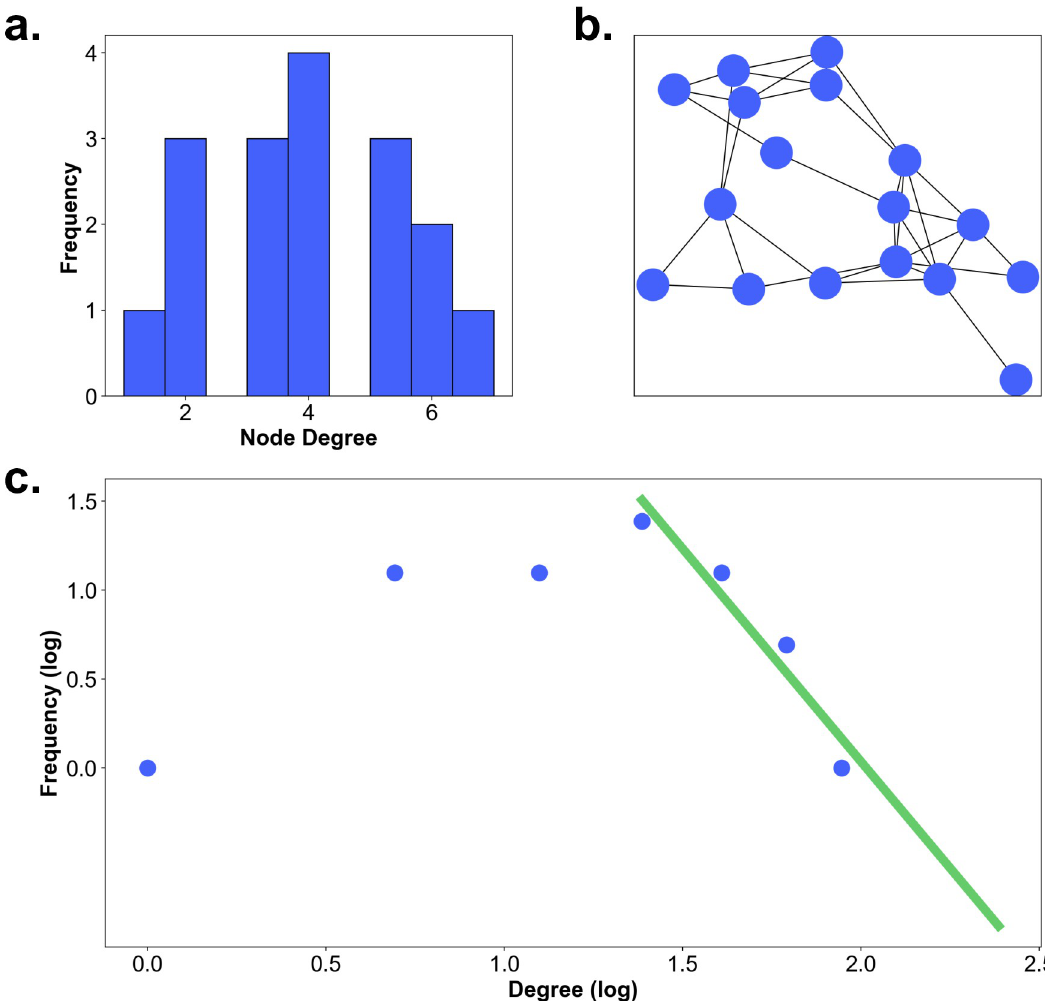
Fig 13. Hierarchy index–Toy example. (a) The node degree distribution of the example graph. (b) The example graph (c) A scatter plot of the logarithm of degree against the logarithm of the frequency of occurrence. The green line shows the linear fit to the part of the data above the median